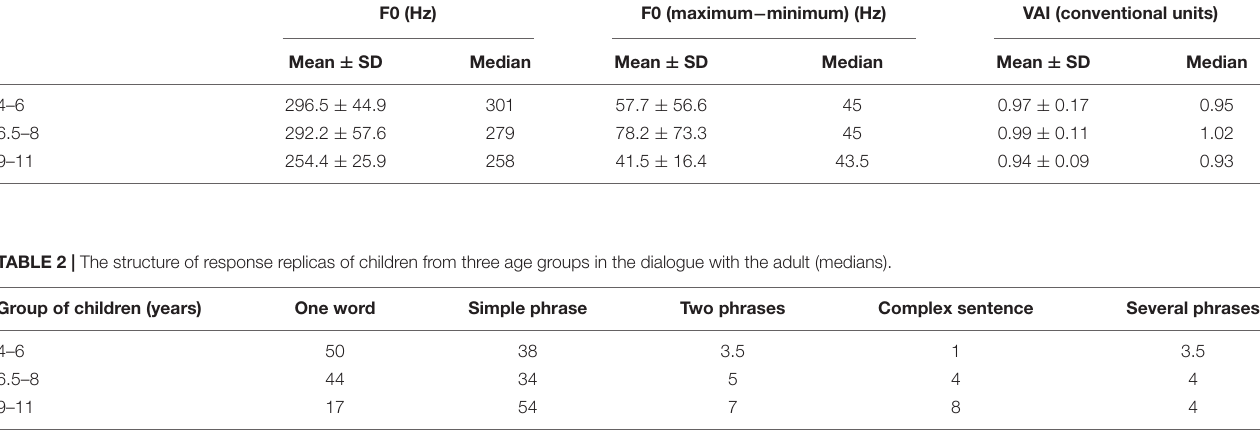
TABLE 3 | The number of children (%) in each age group with the different expression of alpha, theta, and delta in the EEG pattern. No. EEG rhythms The characteristic of rhythm expression